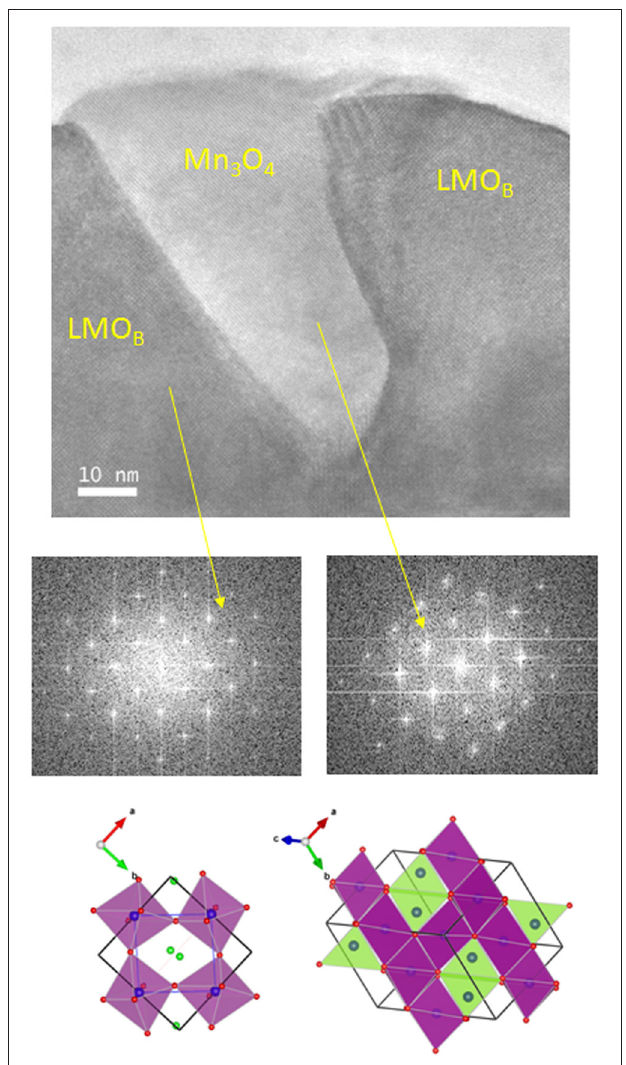
FIGURE 8 | HRTEM images of a Mn 3 O 4 embedded at inside a LMO domain with [001] zone axis. Middle panels show the corresponding FFT images obtained from HRTEM images. Schematic representation of the epitaxial relationship is shown in lower panels. Planes used to define epitaxy are painted in green. For clarity, coordination of Manganese cations (blue) is shown in octahedral (purple) and tetrahedral (green) positions. Oxygen anions in red and Lanthanum cations in blue are also